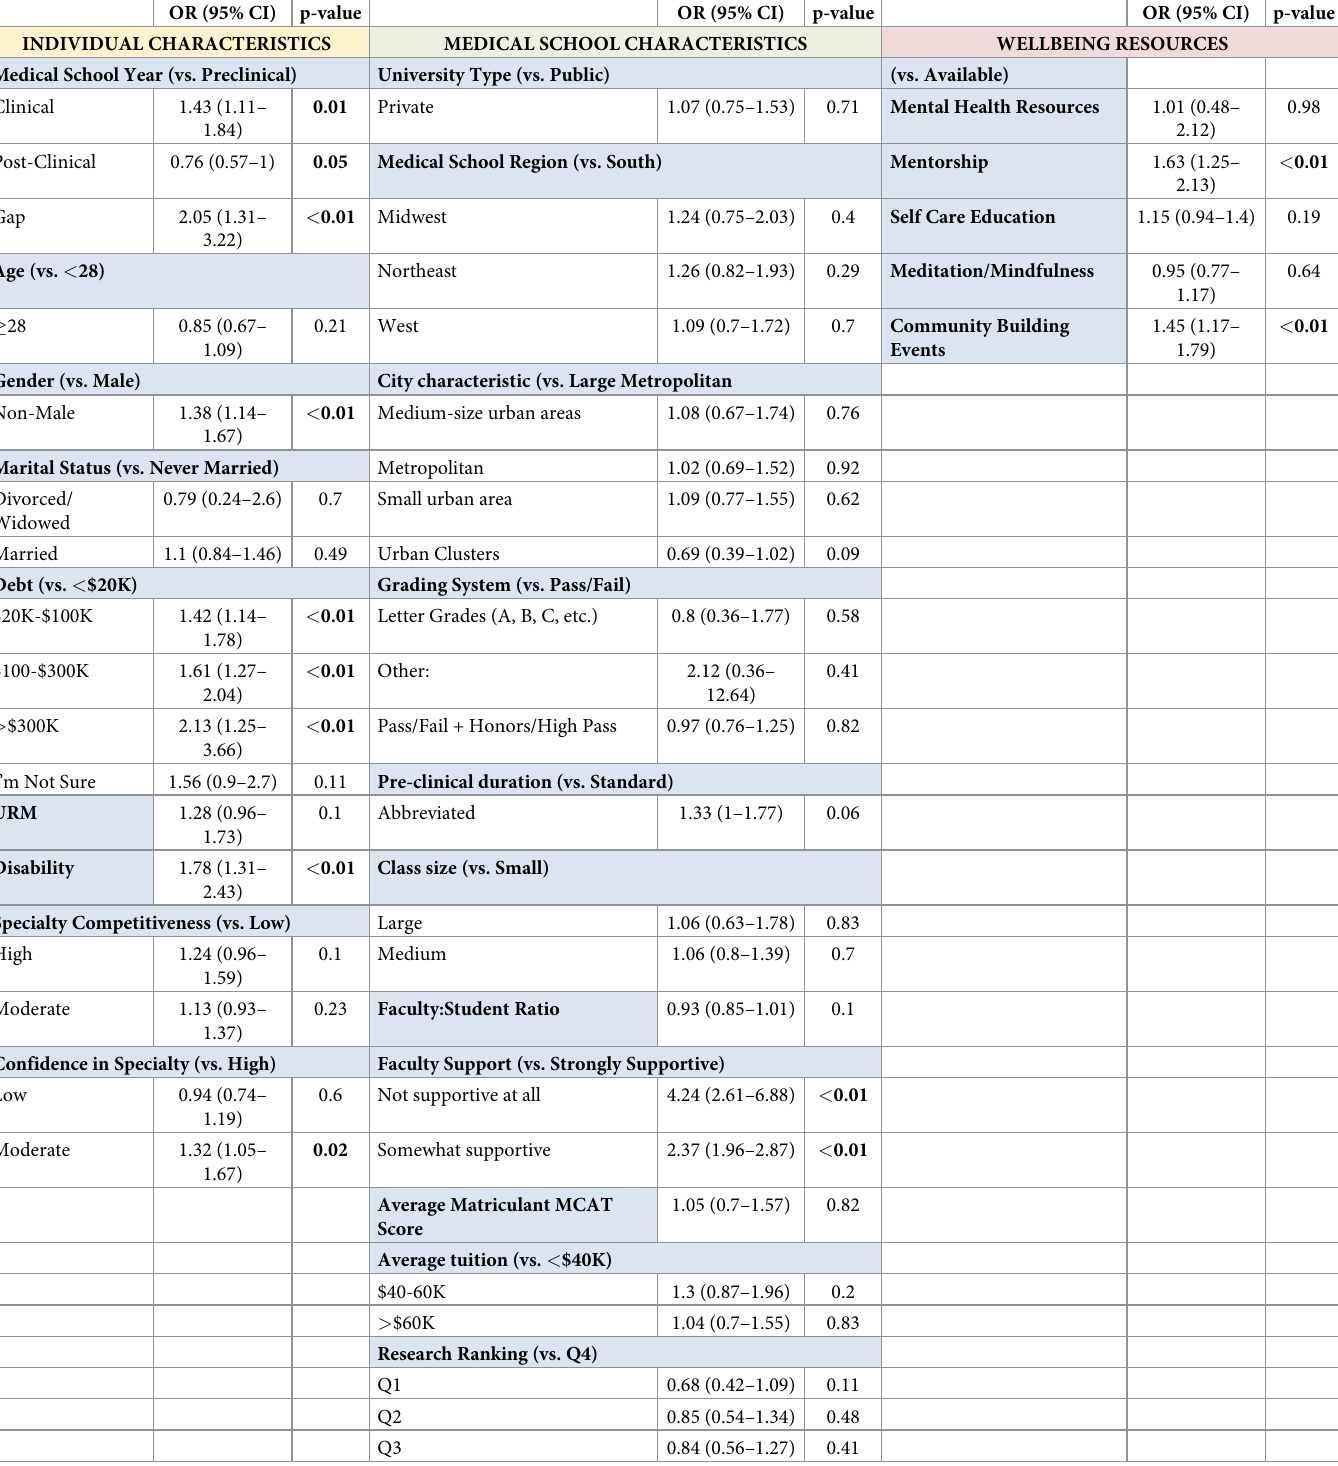
Table 2. Impact of medical school characteristics on student distress (multivariate